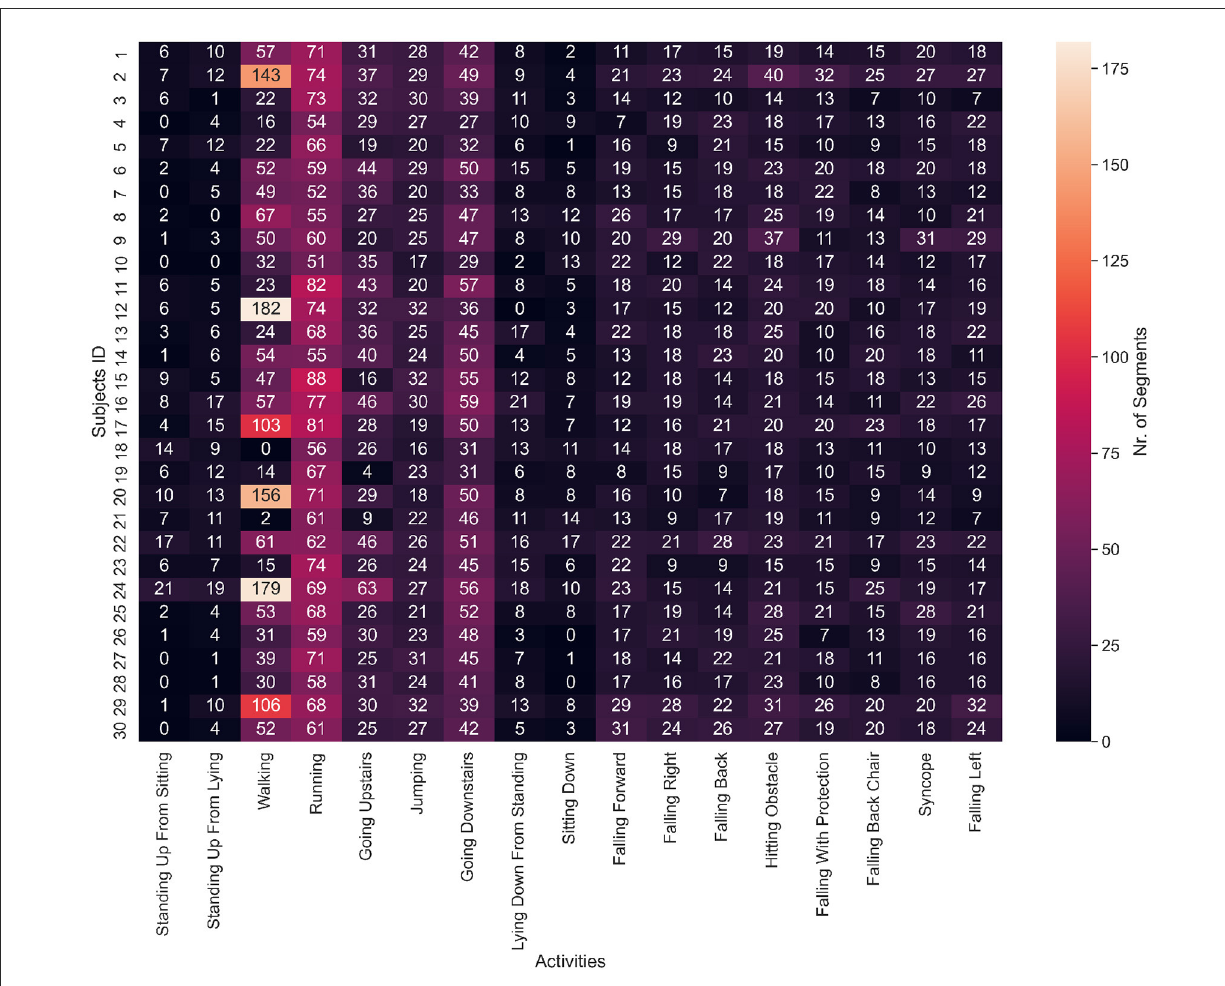
FIGURE4 Heat map of the number of segments for each ADL or fall and subject. Subjects 4, 7, 8, 10, 12, 18, 26, 27, 28, and 30 are missing at least one type of ADL or fall. Walking, running and going downstairs are clearly the predominant activities by the number of segments.